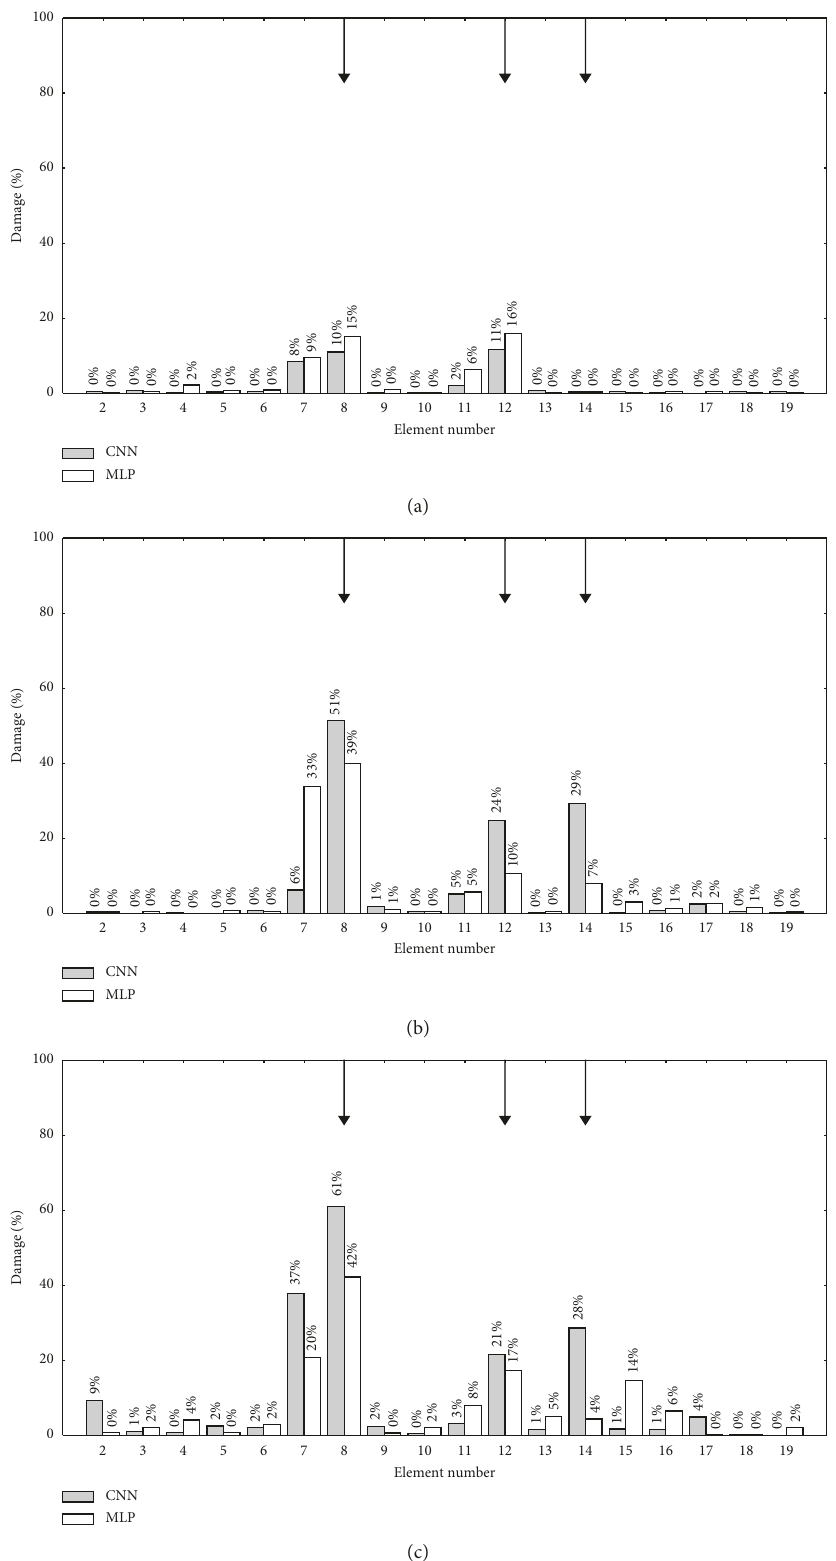
Figure 24: Results for damage scenario 4 according to (a) CNN and MLP models 1, (b) CNN and MLP models 2, and (c) CNN and MLP models